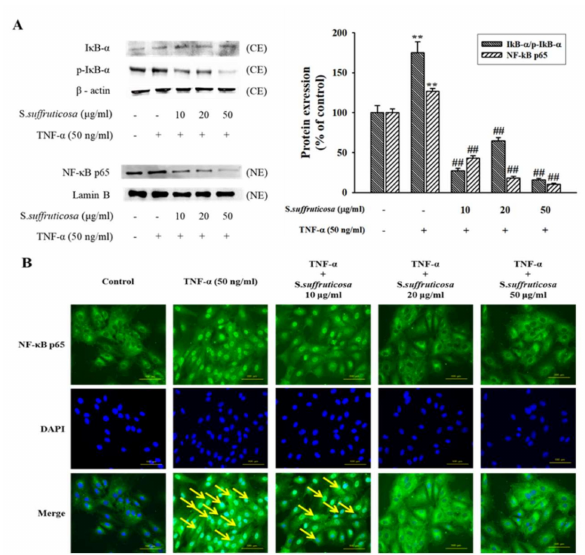
Figure 6. E ff ects of Securinega su ff ruticosa on TNF- α -induced NF- κ B p65 expression. The nuclear protein extract (NE) and cytoplasmic protein extract (CE) were prepared and separated on 10% SDS (Sodium dodecyl sulfate)-PAGE (Polyacrylamide gel electrophoresis) and blotted with the antibodies specific for I κ B- α , p-I κ B- α and NF- κ B p65 ( A ). Immunostaining of NF- κ B p65 by using a monoclonal antibody (green), nuclei stained with DAPI (blue) and composite images generated by superimposing photographs. Each photograph is representative of the results from five independent experiments (original magnification × 400) ( B ). ** p < 0.01 vs. control, ## p < 0.01 versus. TNF- α